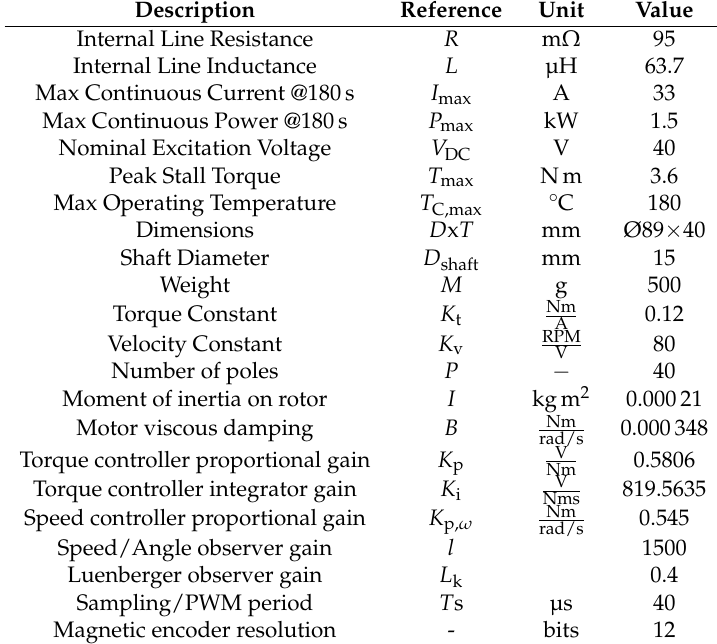
Table A1. Specifications of the U10PLUS KV80 motor and the controllers.